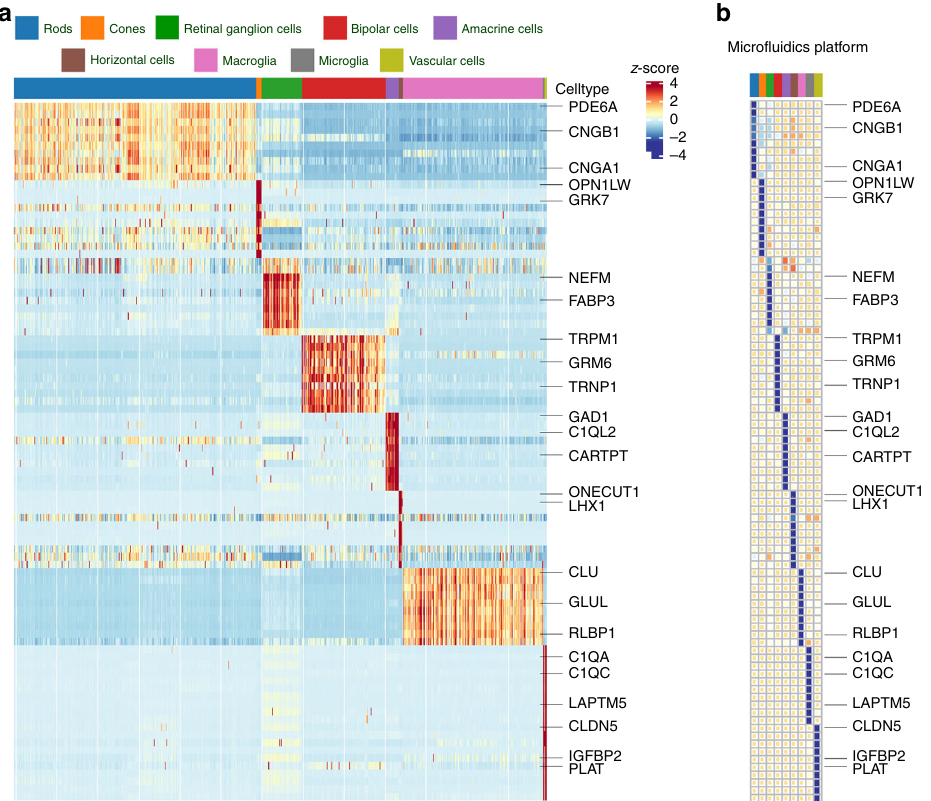
Fig. 2 Heatmap of top marker genes within retinal cell types using micro fl uidics scRNA-seq. The top differentially expressed genes were selected using the one-sided Wilcoxon rank-sum test, and ranked based on their discriminating scores within each identi fi ed cell type. a Imputed gene expression, using network diffusion, across all cells, b Average of raw expression of each gene within each cell-type. In both panels, rows correspond to genes and columns to cell-types, which are color-coded (color bar,